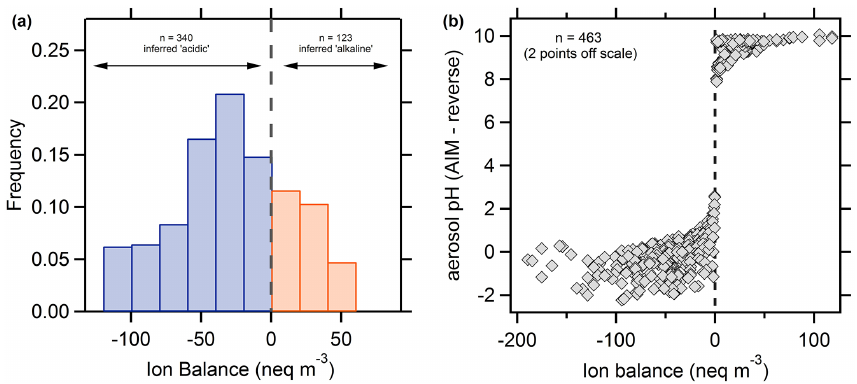
Figure 5. (a) Frequency distribution of the aerosol ion balance during MILAGRO, and (b) aerosol pH predicted by E-AIM in the reverse mode vs. the ion balance. The dashed lines at 0 serve as a visual reference for neutral